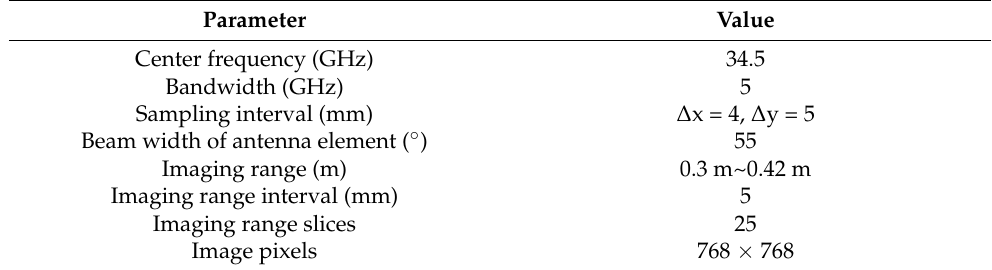
Table 5. Parameters for Measured Data.